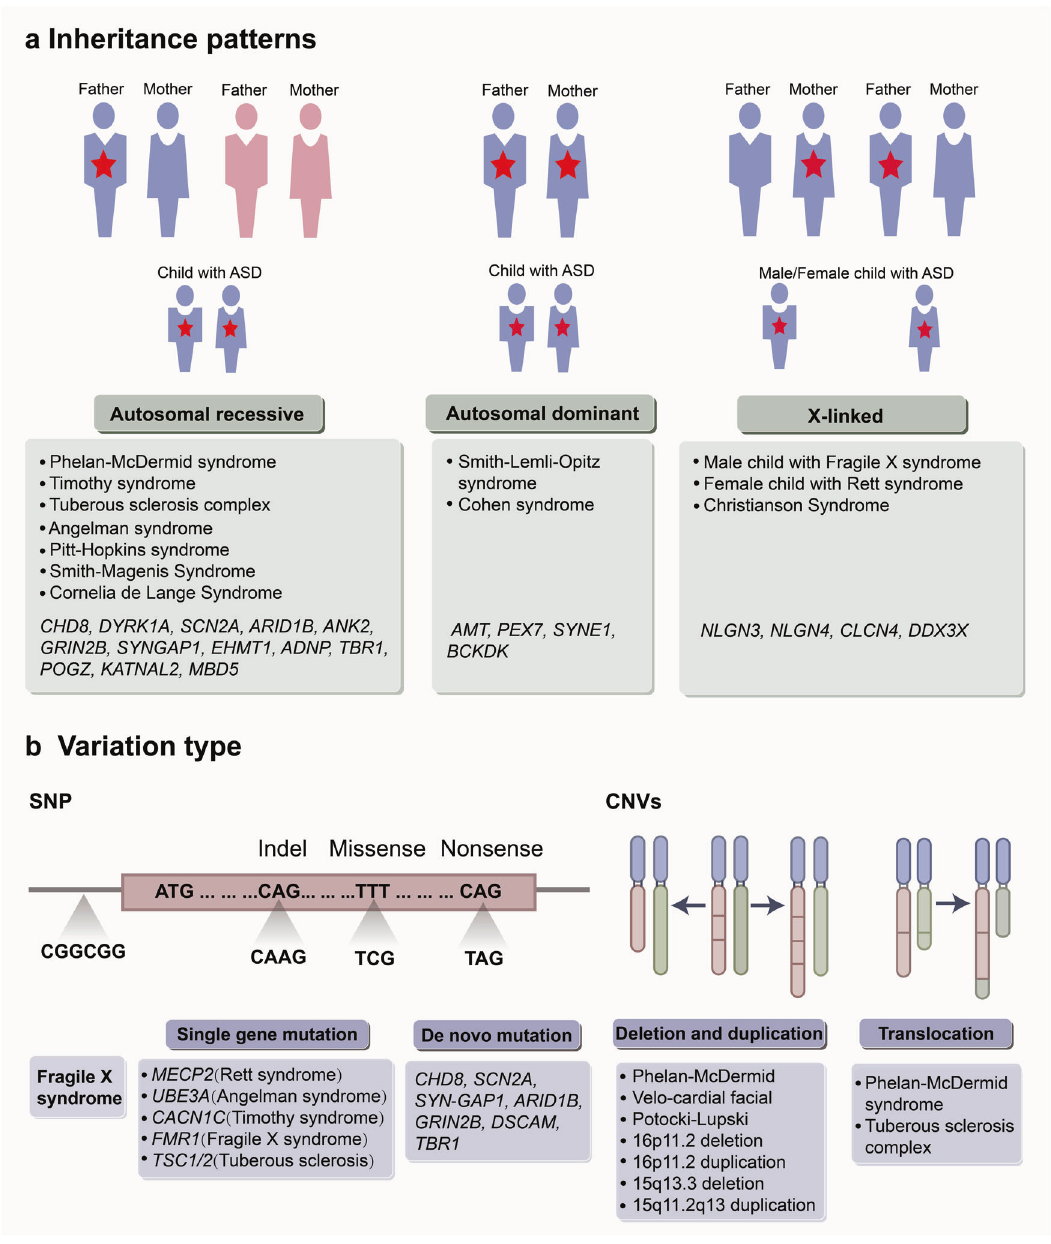
Fig. 2 Genetic architecture of autism spectrum disorder (ASD). a The inheritance patterns of high-risk gene and syndromes associated with ASD. Major gene model includes autosomal recessive, autosomal dominant and X-linked inheritance patterns. The red stars indicate a causal allele. b The shown types of genetic variation including SNP and CNVs. Genes and syndrome that have been associated with ASD are also indicated. SNP single-nucleotide polymorphisms, CNV copy number variation. (Adapted with permission from reference 15